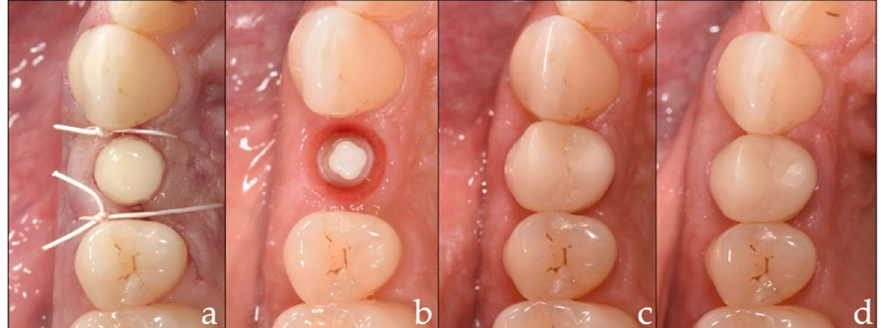
Figure 2. ( a – d ) Implant restoration: ( a ) prefabricated zirconia cap situation; ( b ) final impression; ( c ) baseline examination; ( d ) 1-year follow-up.